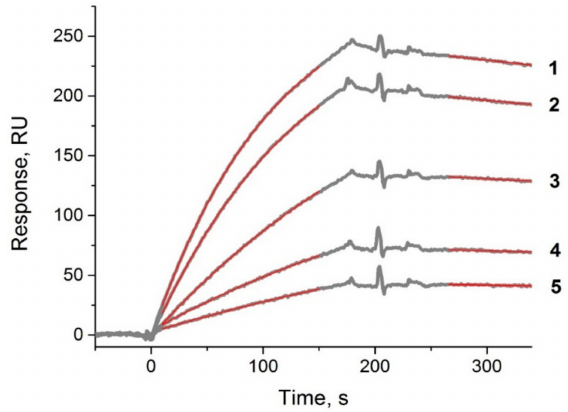
Figure 3. Sensograms for the binding of anti-PVY antibodies at different concentrations with PVY N . Experimental data are shown as thin gray lines; results of curve fittings are shown in the top layer as thick red lines. Numbers designate the concentrations of antibodies (nM): 1—330, 2—240, 3—160, 4—80,